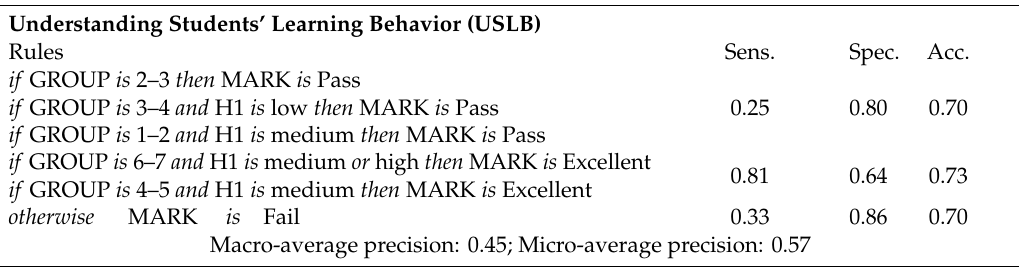
Table 7. ACEP, USLB, ASLP, and GSLB toolbox results for the model 1 of the introductory course. The MARK variable was discretized into three classes: fail (from 0–60), pass (from 61–80), and excellent (from 81–100). H1 was also discretized into three classes: low (from 0–6), medium (from 6.1–8.9) and high (from 9–10). The GROUP is a discrete variable and can take seven di ff erent values; therefore, it is discretized into seven classes. Spec., Sen., and Acc. stand for specificity, sensitivity, and accuracy,